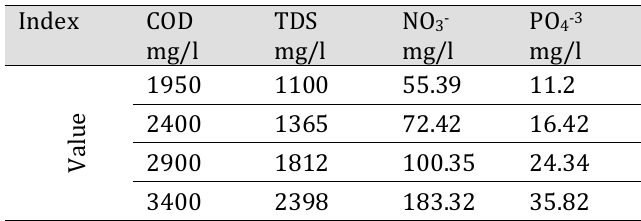
Table 2. Specifications of wastewater used in initial